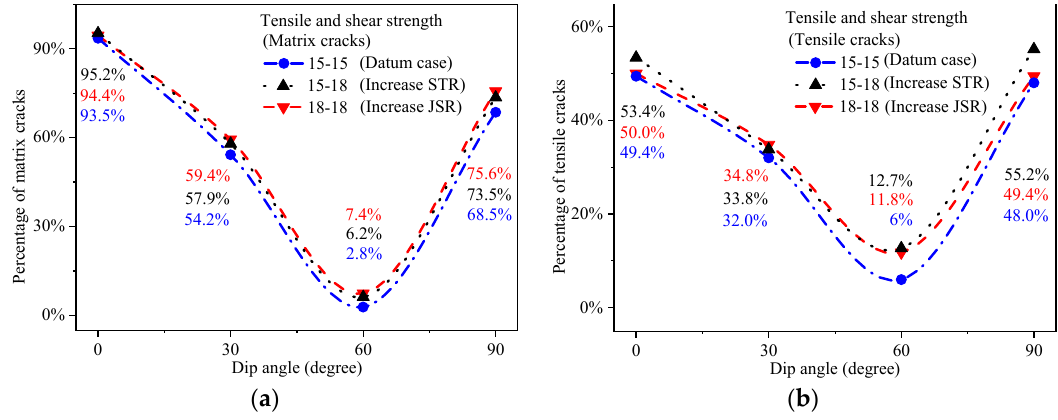
Figure 16. Variation of the percentage of crack types at three bedding parameters: ( a ) matrix cracks; ( b ) tensile cracks.